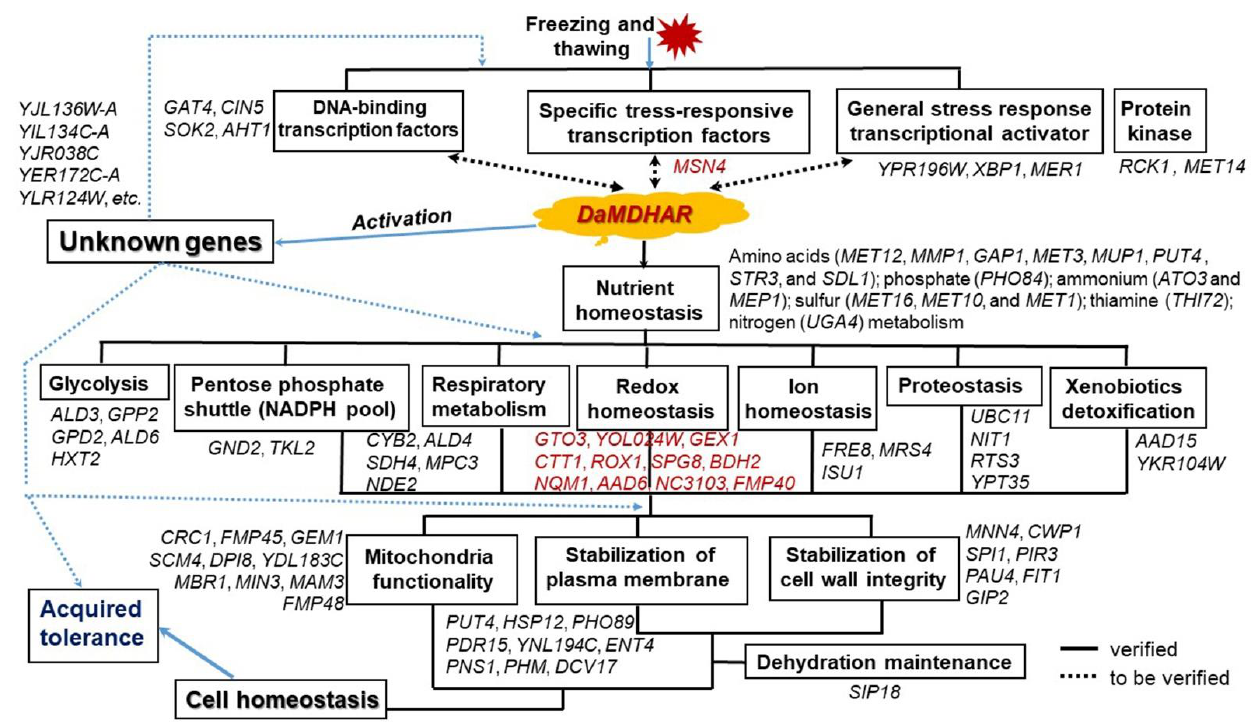
Figure 9. Summary diagram of the adaptive molecular mechanism involved in FT2 stress response in DaMDHAR -expressing yeast cells.